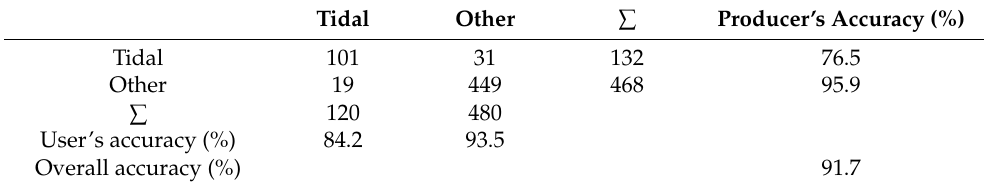
Table 4. Waterline method confusion